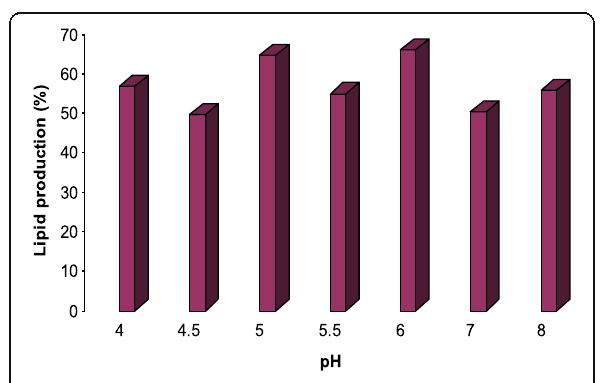
Fig. 3 Effect of initial pH on F. oxysporum NRC 2017 lipid production